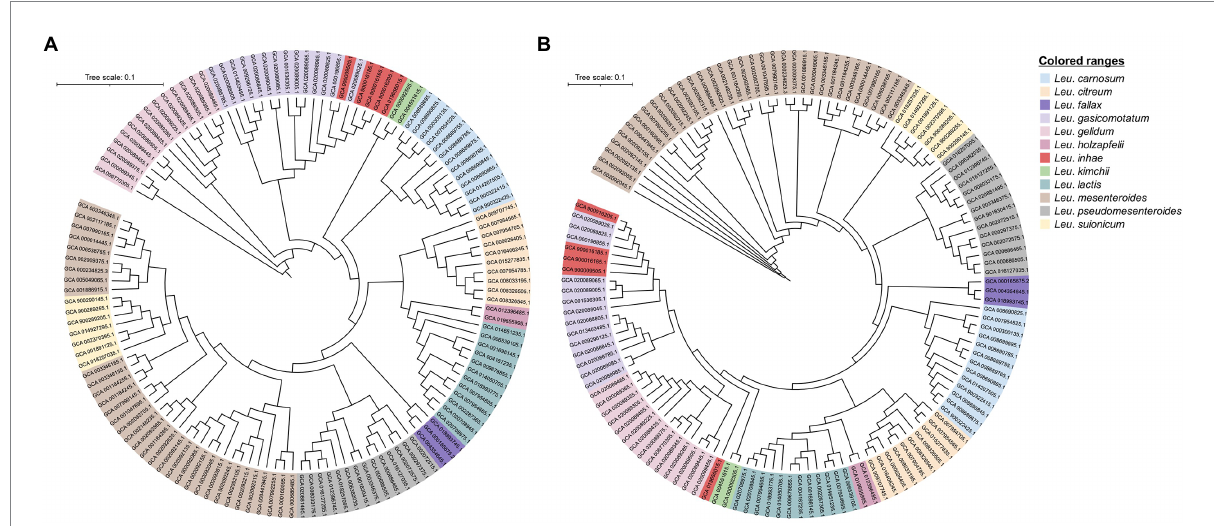
FIGURE 1 Phylogenetic relationship between 130 Leuconostoc strains. (A) Pangenome phylogenetic tree based on binary panmatrix (gene presence/ absence (1/0) matrix). (B) Core-genome phylogenetic tree based on concatenated core gene alignment. Trees were visualized using Interactive Tree of Life